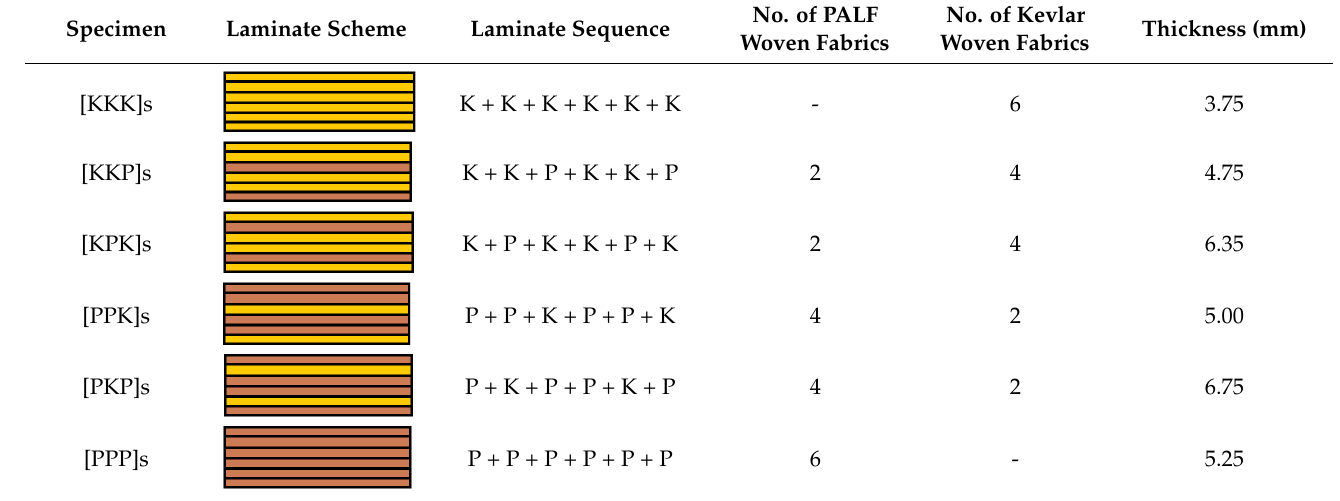
Table 2. Composition of PALF and Kevlar laminate schemes in the hybrid composite. Specimen